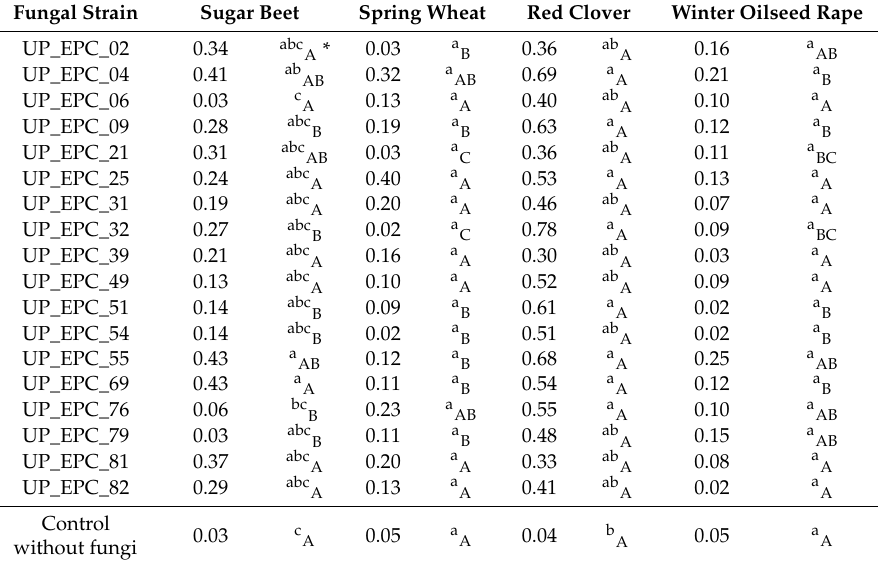
Table A5. Disease index of seedlings of sugar beet ( B. vulgaris L. ssp. vulgaris ), spring wheat ( T. aestivum L.), red clover ( T. pratense L.), and winter oilseed rape ( B. napus L.) colonized by 18 strains of E. nigrum .